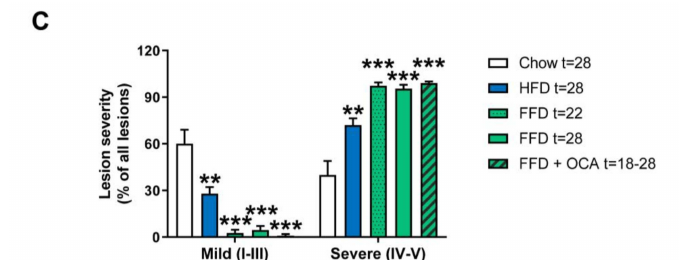
Figure 5. Representative images of atherosclerotic plaques in aortic root section ( A ) stained with hematoxylin–phloxine–sa ff ron (HPS) from Ldlr − / − .Leiden mice fed a healthy chow diet for 28 weeks or fed a high-fat diet (HFD) for 28 weeks or fed a fast food diet (FFD) for 22 or 28 weeks. In addition, mice were fed the FFD and supplemented with a relatively low dose of OCA (10 mg / kg / d) from weeks 18 to 28. Total lesion area per cross-section was quantified ( B ) and lesion severity ( C ) was assessed, categorized as mild lesions (type I–III) and severe lesions (IV–V). Values represent mean ± SEM for ≥ 8 mice per group. ** p < 0.01 and *** p < 0.001 vs.